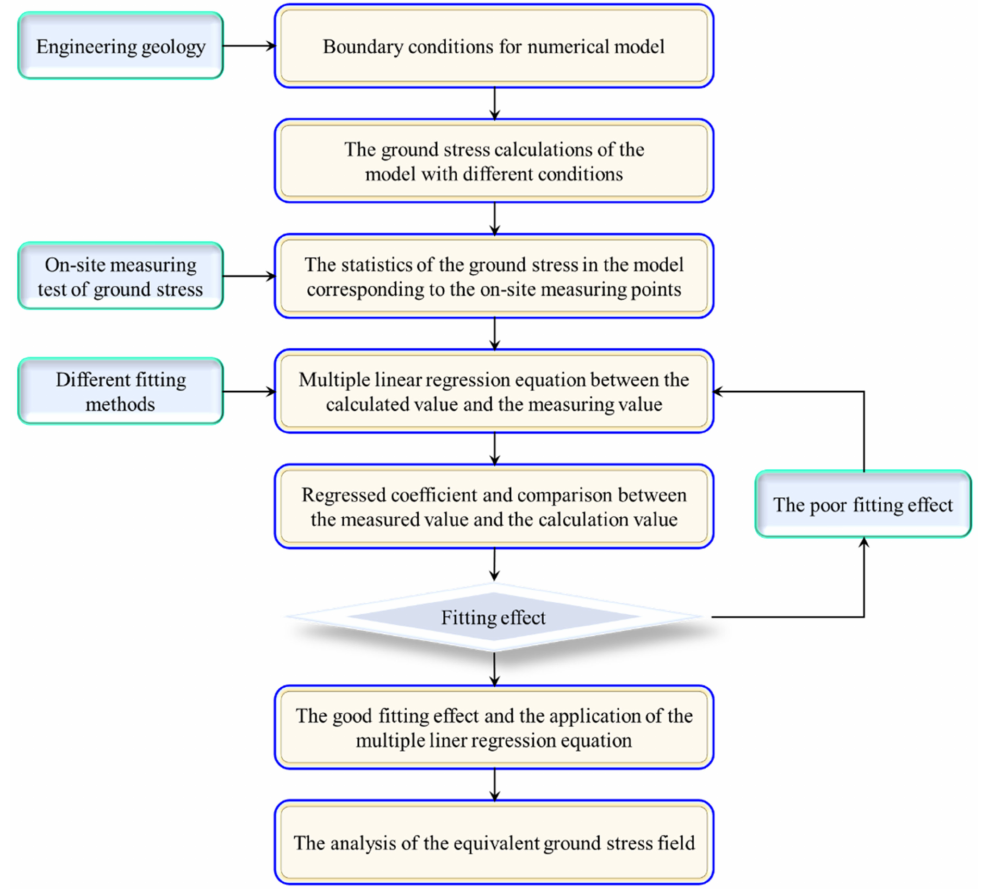
Figure 1. Principle of regression inversion of initial ground